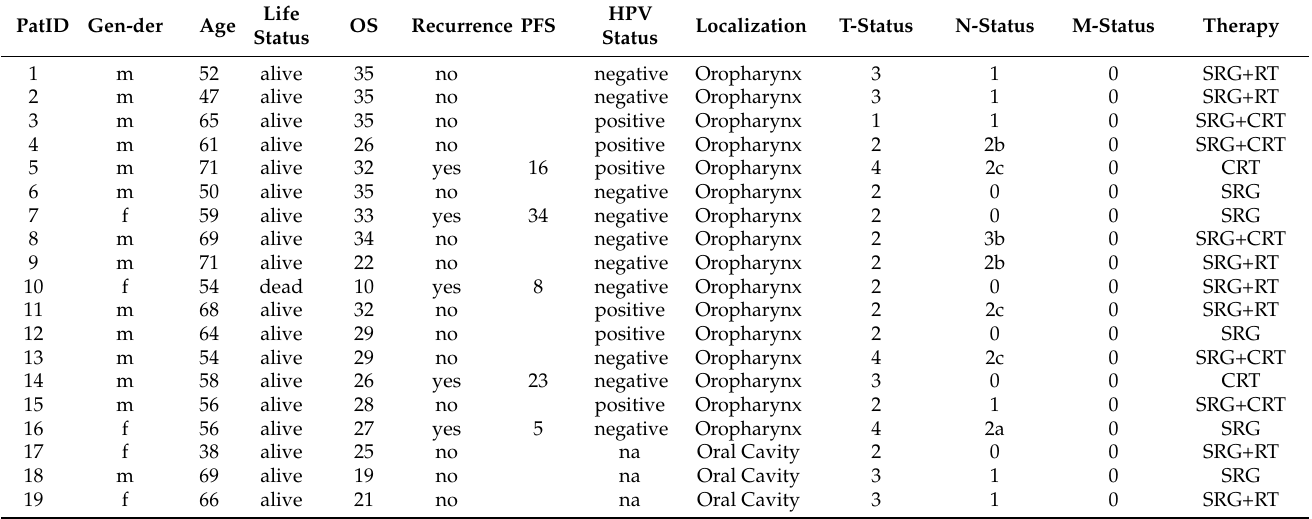
Table 1. Tabular patient characteristics with their ID, gender, age, life status, recurrence status, HPV status, localization, TNM Status, and